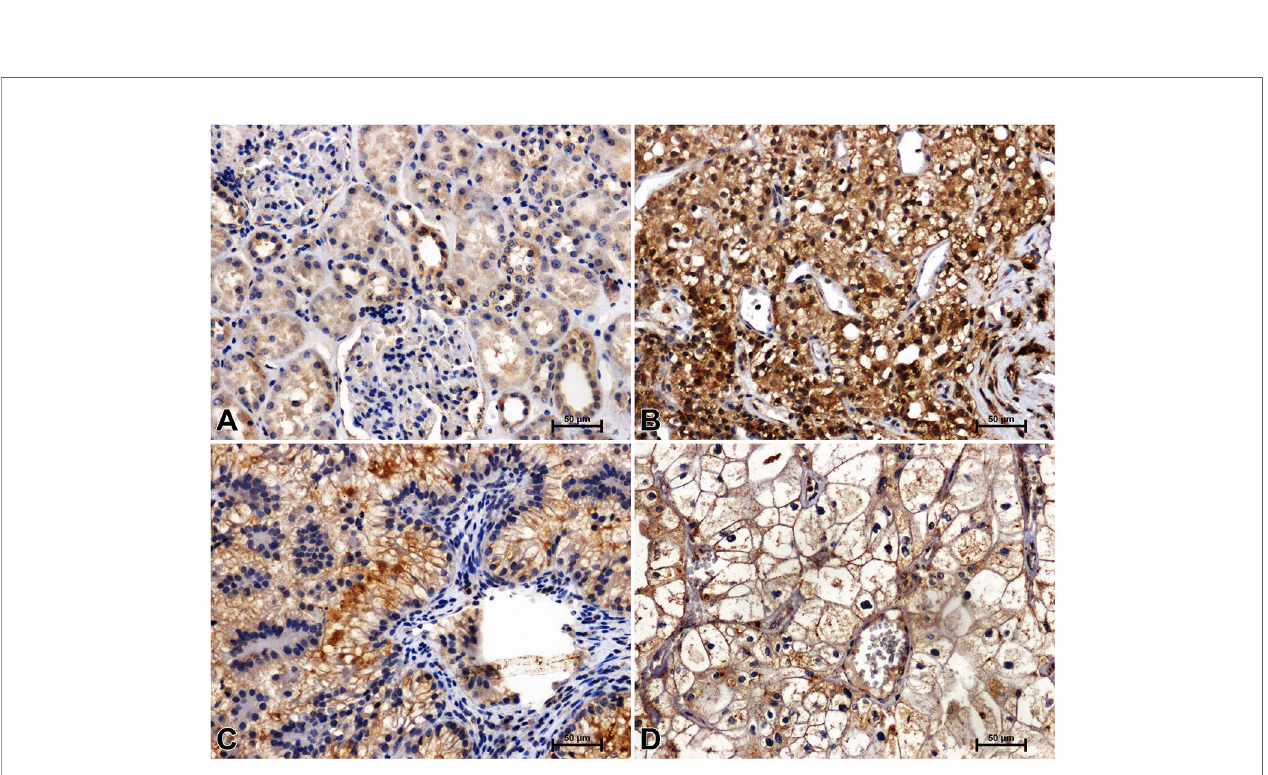
FIGURE 2 | Immunodetection of Fzd5 in non-malignant kidney (A) and clear cell RCC (B) , papillary RCC (C) , chromophobe RCC (D) .